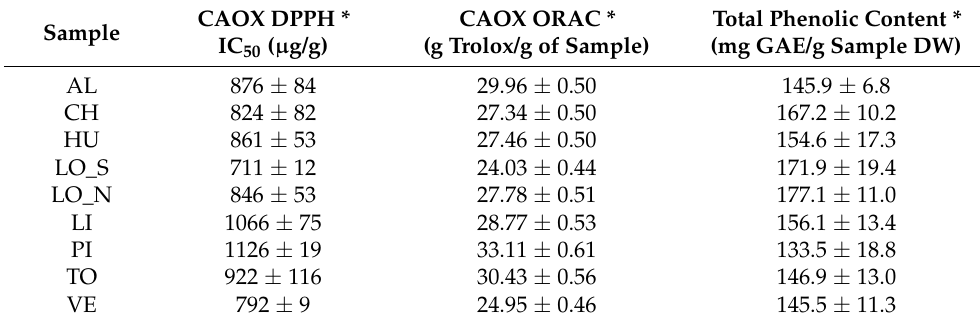
Table 3. Results of antioxidant capacity obtained by ORAC and DPPH methods and total phenolic